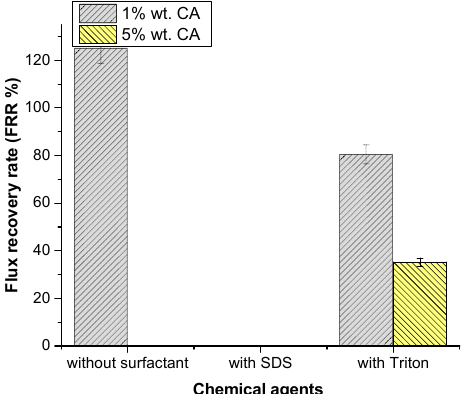
Figure 6. Effect of chemical agents on flux recovery by acidic cleaning.